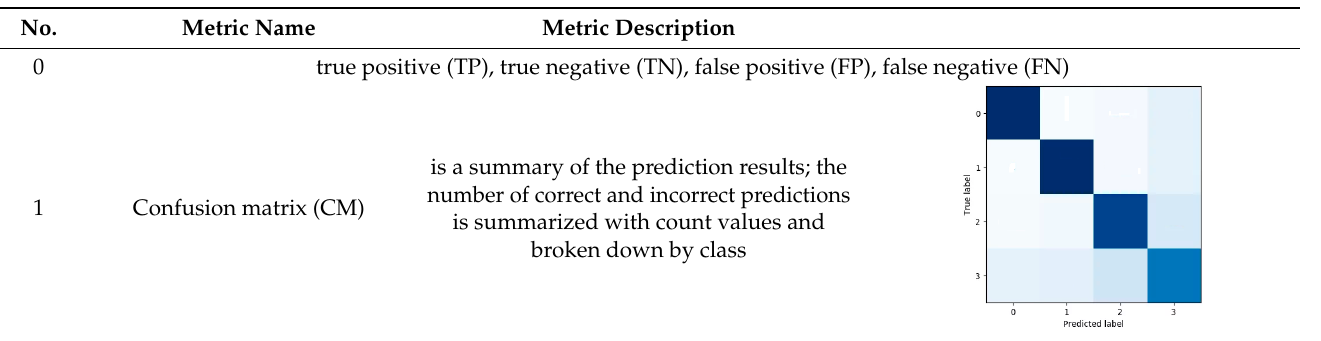
Table 3. Classification model evaluation metrics (adapted from [49]).